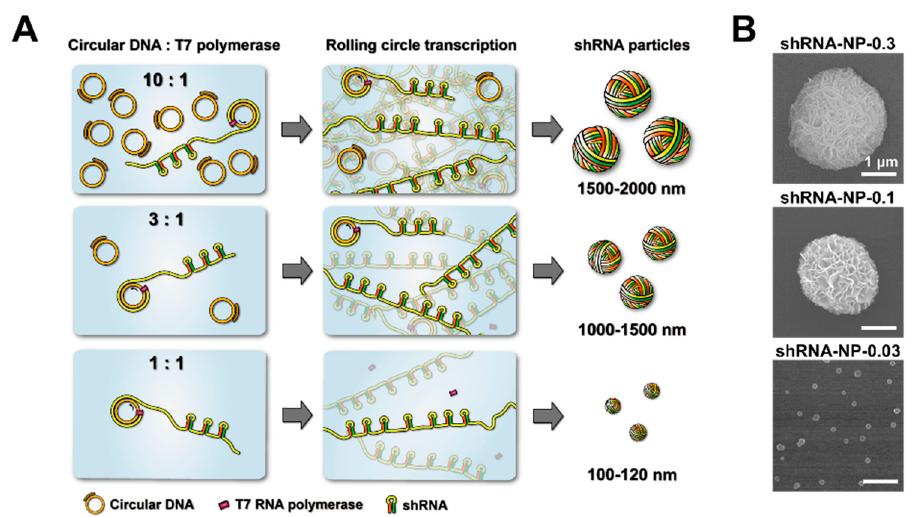
Figure 1. ( A ) Schematic illustration outlining the size-controlled synthesis of short hairpin RNA (shRNA) particles. By controlling concentrations of circular DNA in the rolling circle transcription (RCT) reaction at the same unit concentration of T7 RNA polymerase, the sizes of resulting RCT-mediated self-assembled shRNA particles could be controlled; ( B ) Scanning electron microscopy (SEM) images of shRNA particles showing their different sizes.